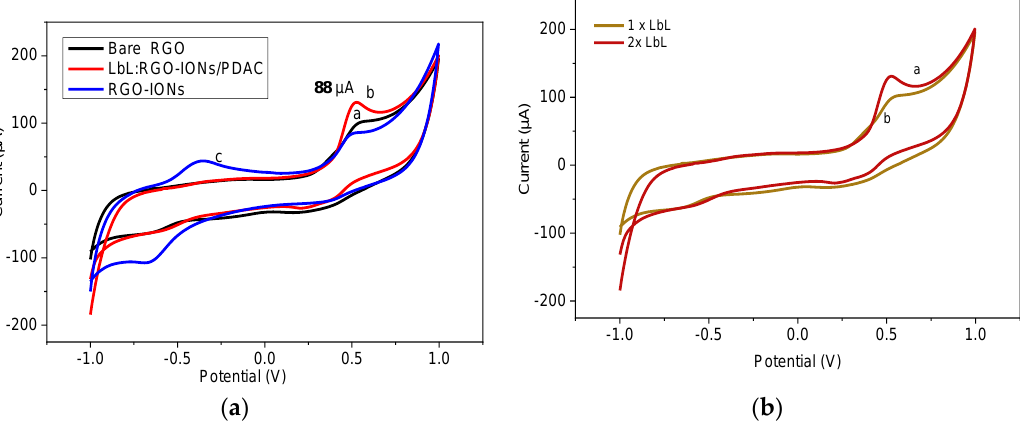
Figure 9. Cyclic voltammograms of ( a ) bare RGO, ION-RGO and LbL of RGO-IONs/PDAC in 0.1 M PBS solution (pH 5.7) with 1 mM NaNO 2 ; ( b ) one bilayer of PDAC and RGO-IONs and two bilayers in 0.1 M PBS solution (pH 5.7) with 1 mM of NaNO 2 .